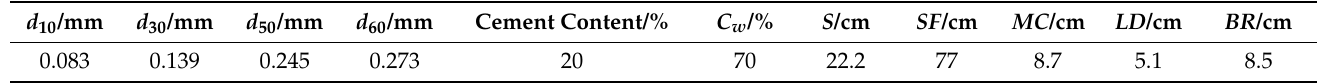
Table 5. Tailings grain size characteristics, slurry configuration parameters, and flow test results in the Dazhong